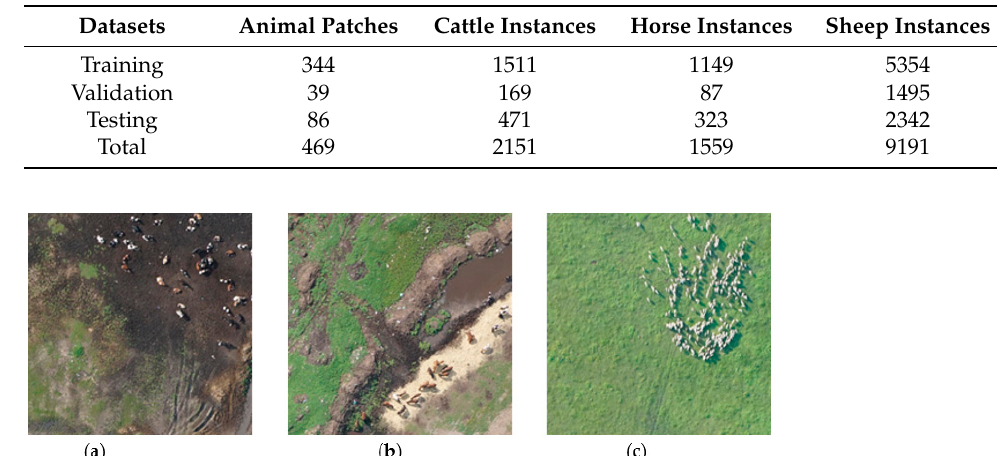
Figure 2. The split UAV image. ( a ) The original UAV image. The overlapped blue areas are 100 pixels wide to prevent the object from being split. ( b ) The subpatches after split are images in our dataset. The size of them is 1024 × 1024. ( c ) The annotation of samples using Labelme. Seventy-five original UAV images with livestock were selected, and after the split, there were a total of 4050 image subpatches, including 469 animal patches (images containing animals), to build the dataset. The set was randomly divided into training, validation, and testing datasets with a ratio of about 7:1:2. More details about dataset allocation are shown in Table 1. Figure 3 shows the image samples in the dataset containing three types of animals: ca tt le, horses, and sheep. Figure 4 shows some object instances of the three types of animals in the dataset. Table 1. The allocation of images into the training, validation, and testing datasets.